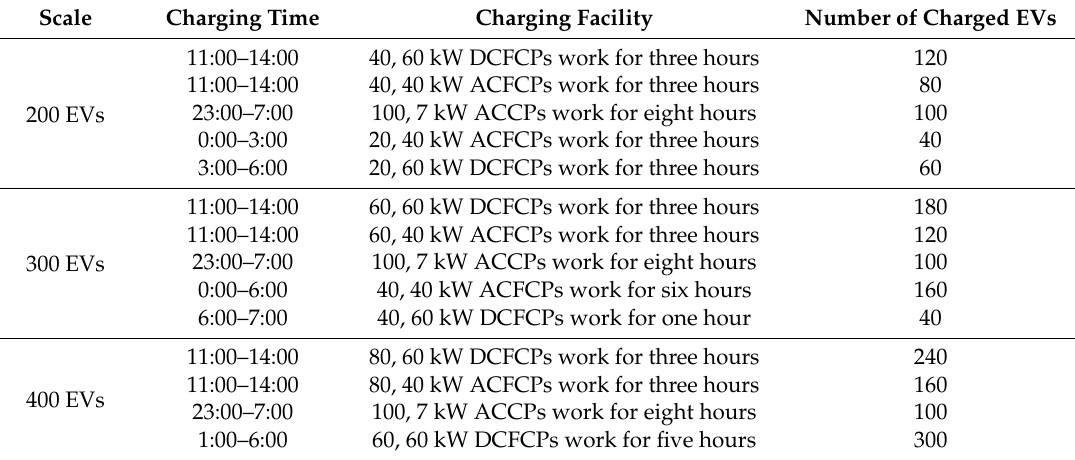
Table 7. Coordinated charging strategies for different scales of EVs.